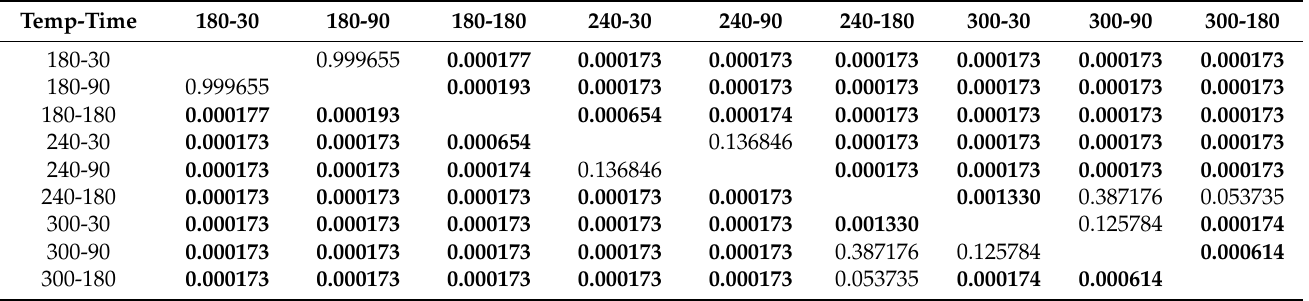
Table A2. Two-way analysis of variance (ANOVA) with post hoc Tukey test for VM content, a bold font signifies a statistically significant difference ( p <